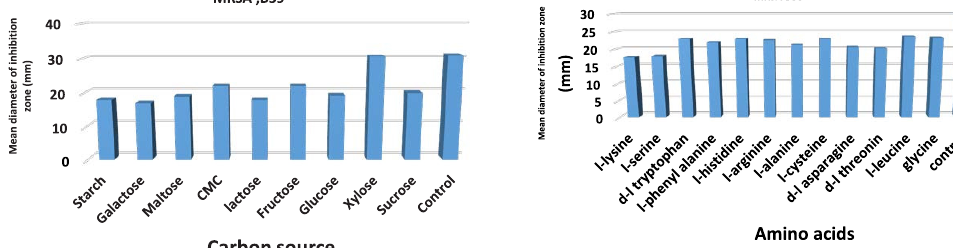
Fig. 2-d. Antimicrobial activity of mixture of ethyl acetate extracts of P. plebeium and E.hirta against MRSA B39 in relation to different amino acids